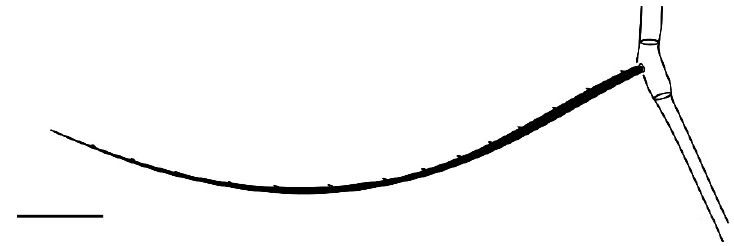
Figure 17. Neophyllobius fissus . Female. Genu IV. Scale bar: 50 μ m.